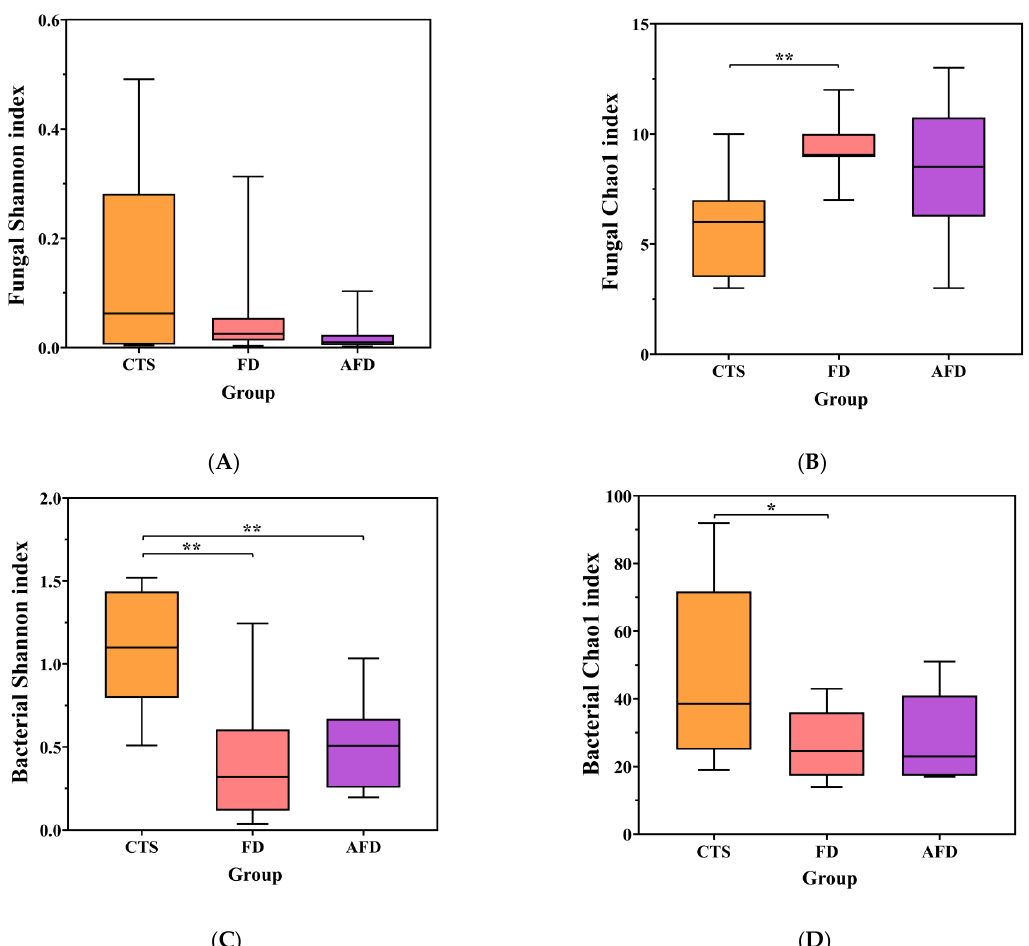
Figure 2. Microbial diversity indexes, including the Shannon and Chao1 indexes of CTS, FD, and AFD. ( A ) Chao1 index of fungi. ( B ) Shannon index of fungi. ( C ) Chao1 index of bacteria. ( D ) Shannon index of bacteria. * p < 0.05; ** p < 0.01.